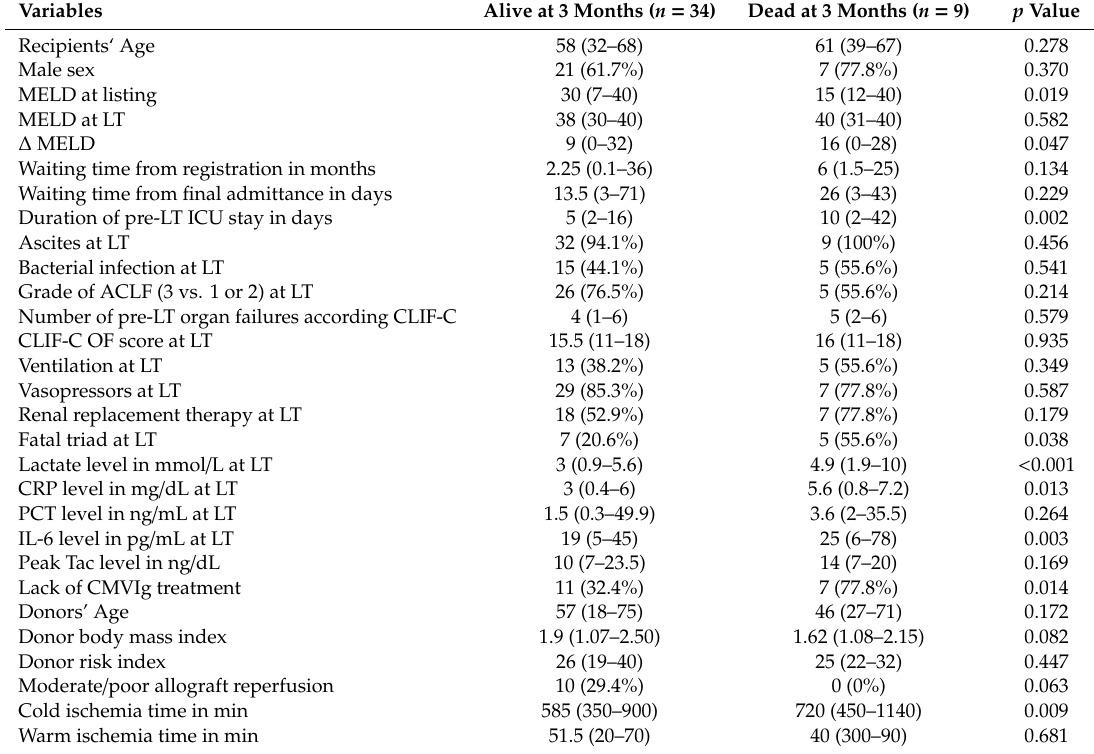
Table 3. Univariate prognostic factors of 3-month mortality.